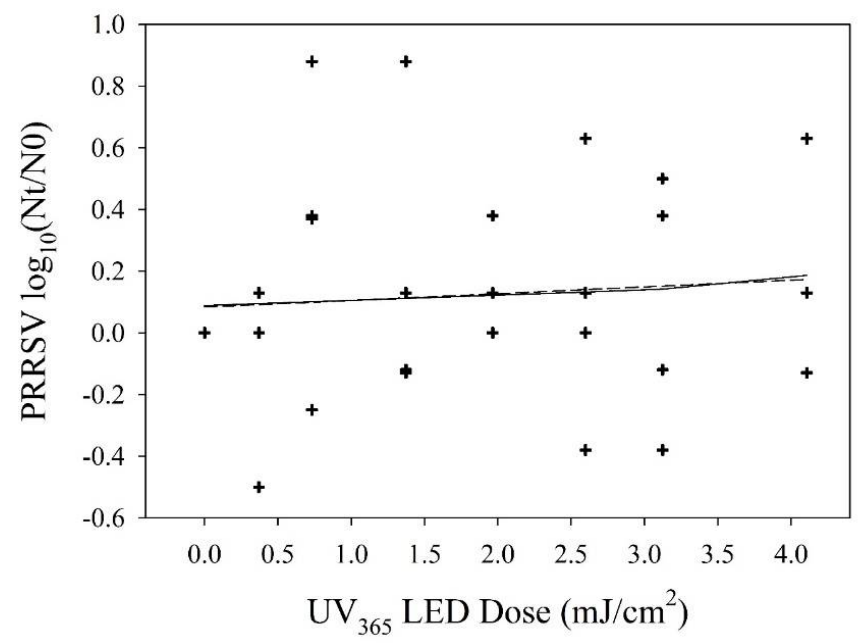
Figure A4. UV-A (365 nm, LED) treatment inactivation curve on aerosolized PRRSV. One-stage (dashed line) and two-stage (solid line) inactivation curves were drawn. PRRSV survival is expressed as log 10 (N t /N 0 ), not as a percentage (%) shown in Figure 5.